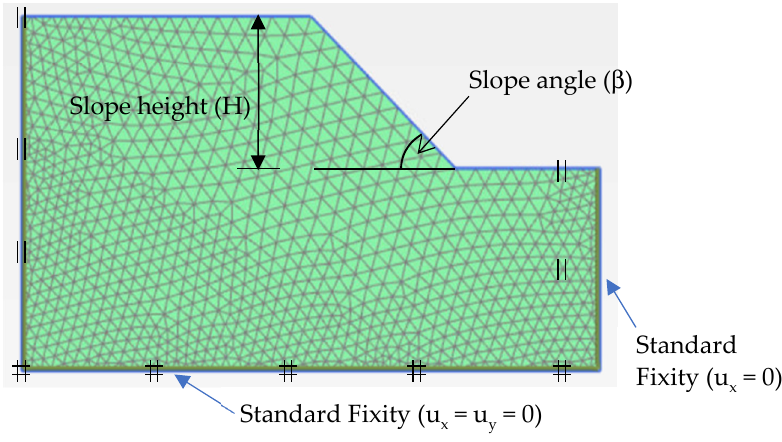
Figure 8. Typical finite element mesh for the slope model in PLAXIS 2D.